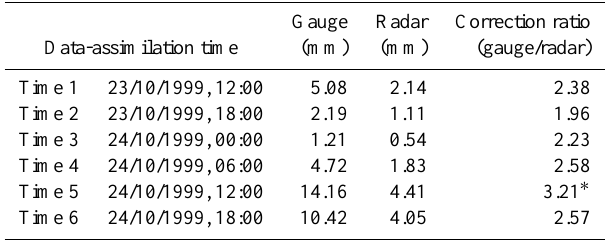
Table 2. Correction ratios for the Wardon Hill radar data at the data- assimilation times.